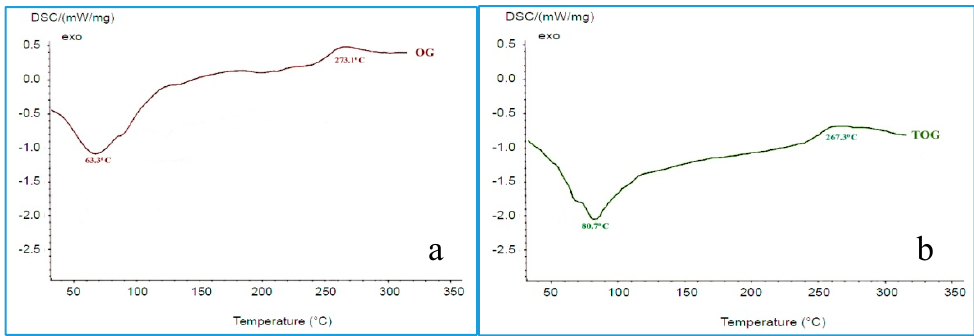
Figure 3. Differential scanning calorimetry (DSC) thermograph of OG ( a ) and TOG ( b ).